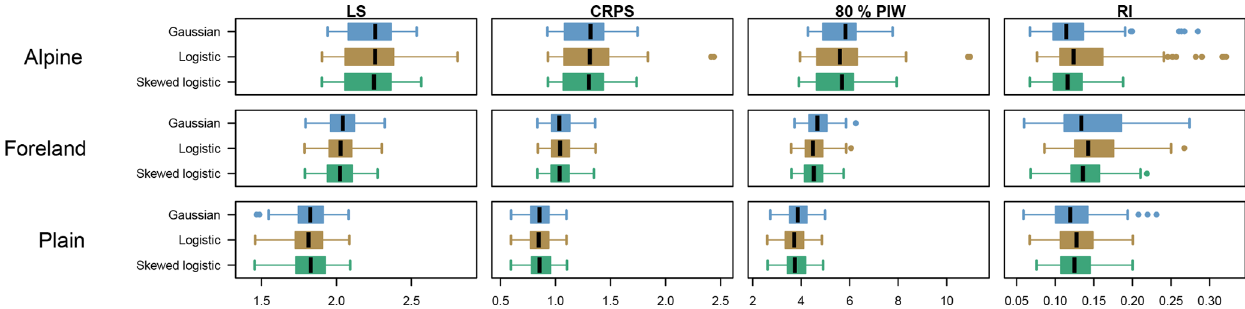
Figure 6. Performance measures in terms of LS, CRPS, 80% PIW, and RI (left to right), clustered for Alpine, foreland, and plain sites (top to bottom). The box and whiskers are based on average scores for each station and lead time, with the boxes illustrating the interquartile range (0.25–0.75), the whiskers denoting ± 1 . 5 times interquartile range, and the solid circles representing outliers.